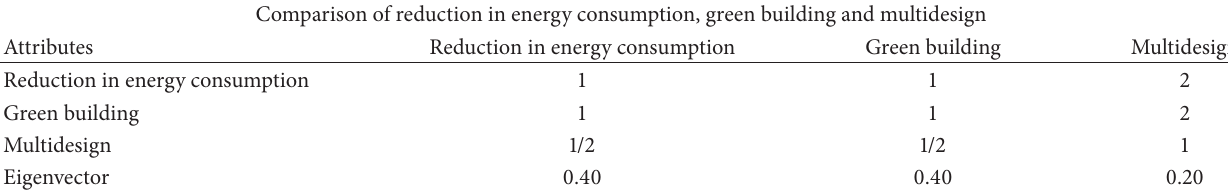
Table 6: Weighting value of design criteria.